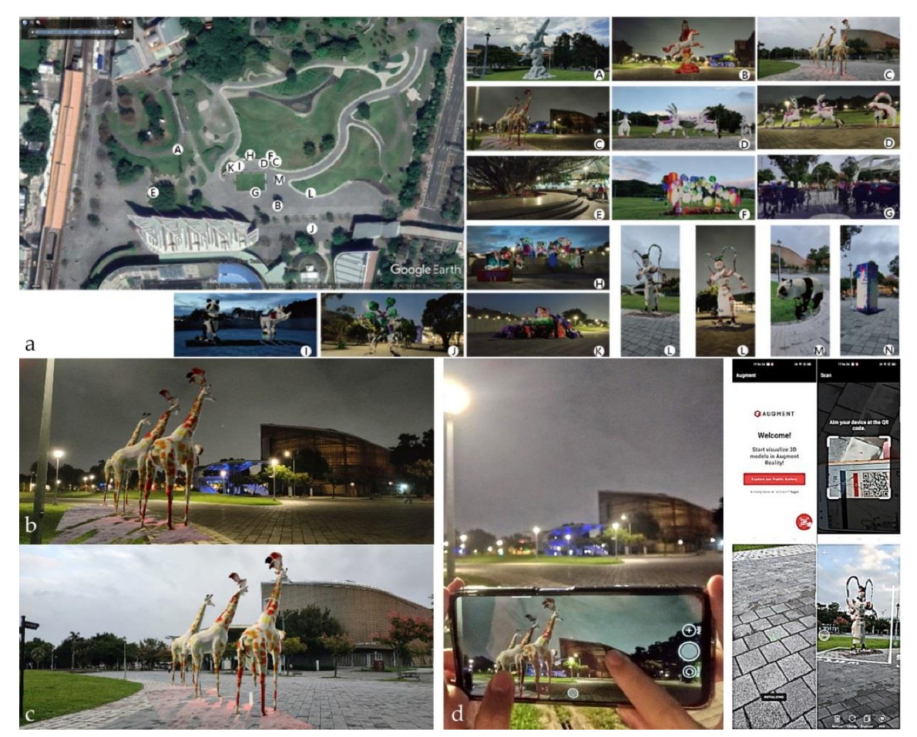
Figure 8. The situated revisit and recall of an old festival with AR screenshots ( a ), screenshots in the evening and late afternoon ( b ), third-person photographs ( c ), and the stepwise operation process: launch app, scan QR code of a selected 3D model, detect plane, tap to allocate the model, and adjust the model’s scale, location, or rotation angles ( d